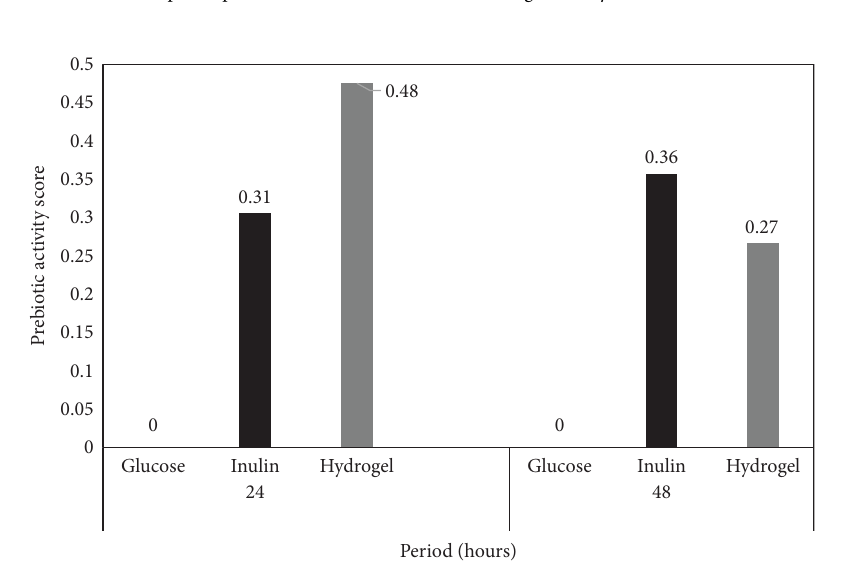
Figure 3: Prebiotic activity score of L. acidophilus FNCC 0051 on glucose, inulin, and hydrogel.